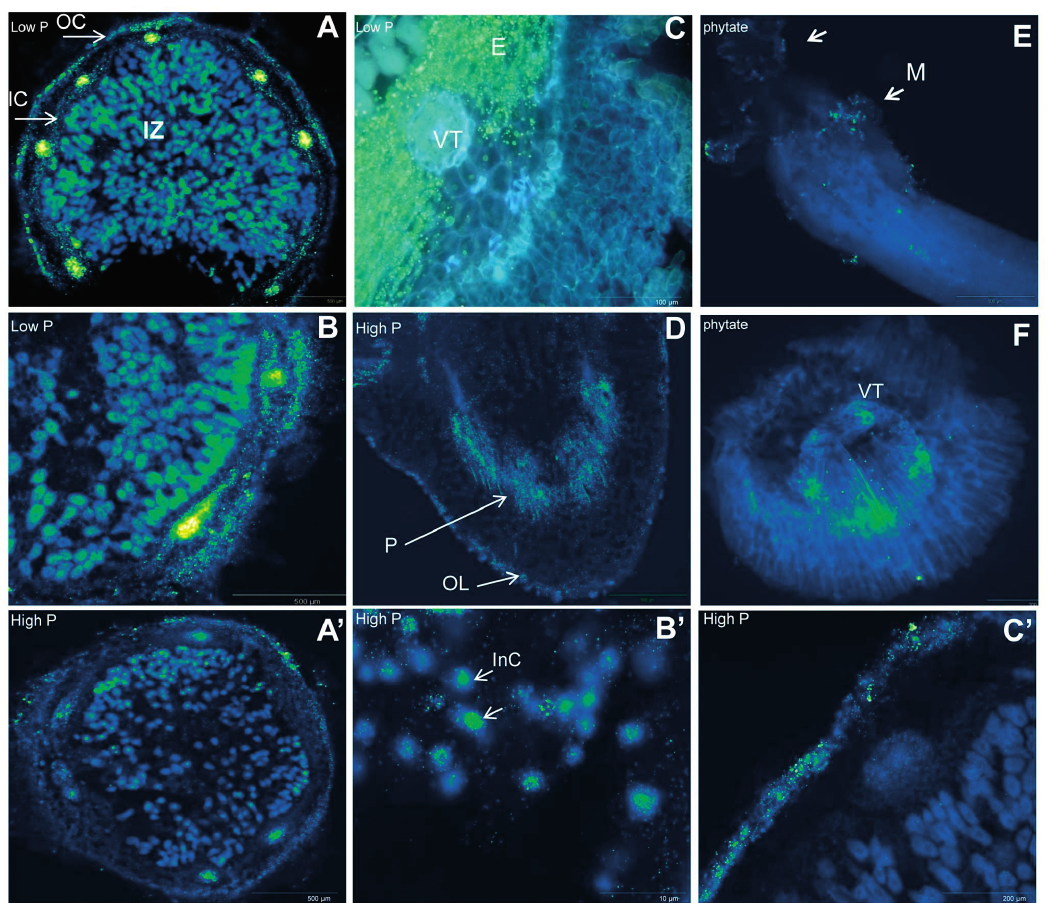
Figure 1. In situ RT-PCR of acid phosphatases transcripts (localization and distribution) in cross sections of nodules and roots of P. vulgaris grown under P-deficiency (low P, 75 µM·P·plant − 1 ). ( A ) Phosphoenolpyruvate phosphatase (500 μ m); ( B ) trehalose 6-P phosphatase (500 μ m); ( C ) phytase transcript (100 μ m); ( D ) phytase transcript in radicle (500 μ m) of germinated seeds ( A – D under P-deficiency); ( E ) beta propeller phytase (BPP) transcripts in root tip mucilage (500 μ m); and ( F ) cross section of root tips (200 μ m) of P. vulgaris inoculated with Bacillus subtilis under phytate supply. Controls under P-sufficiency (high P, 250 µM·P·plant − 1 ) correspond to ( A’ ) (500 μ m) and ( B’ ) (10 μ m) for phosphoenolpyruvate phosphatase and ( C’ ) 200 μ m for nodule phytase. Abbreviations: In nodules: E, Endedormis; IC, inner cortex; InC, infected cells; OC, outer cortex; IZ, infected zone; VT, vascular trace parenchyma; In seeds: OL, outer layers; M, mucilage; P, parenchyma. Images ( A’ – C’ , A , B ); ( C , D ); and ( E , F ) provided by Bargaz A, Lazali M, and Maougal T.R,